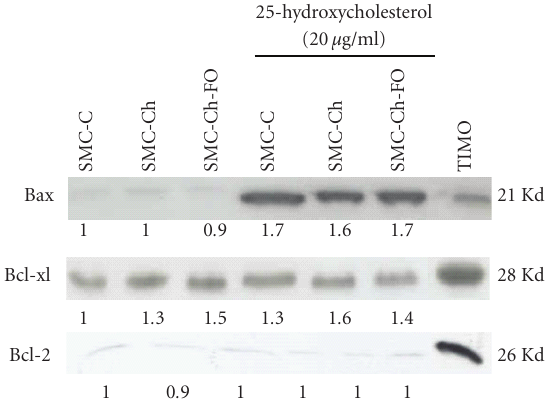
Figure 4: bcl-xl mRNA quantification in SMC cultures (SMC-C, SMC-Ch, SMC-Ch-FO) and SMC cultures treated with 20 μ g/mL 25-hydroxycholesterol for 24 hours. mRNA levels were quantified by real-time semiquantitative reverse-transcription PCR. Results are shown as relative expression ratio of bcl-2xl in SMC cultures with respect to control culture and expressed in comparison to reference gene β -actin. Bars represent the means ± SEM for 3 di ff erent experiments. ∗ P < . 05, ∗∗ P < . 01, ∗∗∗ P < . 001 versus SMC-C, + P < . 05, ++ P < . 01, +++ P < . 001 versus SMC-C treated with 20 μ g/mL